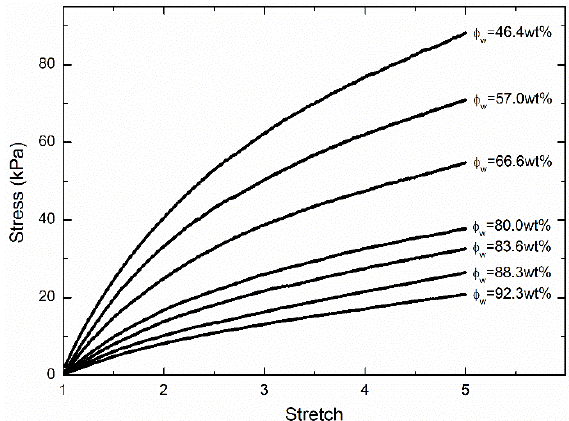
Figure 1. Nominal stress ‐ stretch curve for hydrogels with different water content levels.